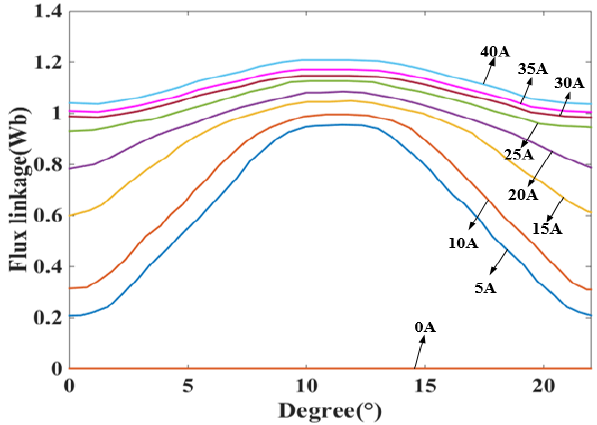
Figure 8. Variation of magnetic chain at different angles.